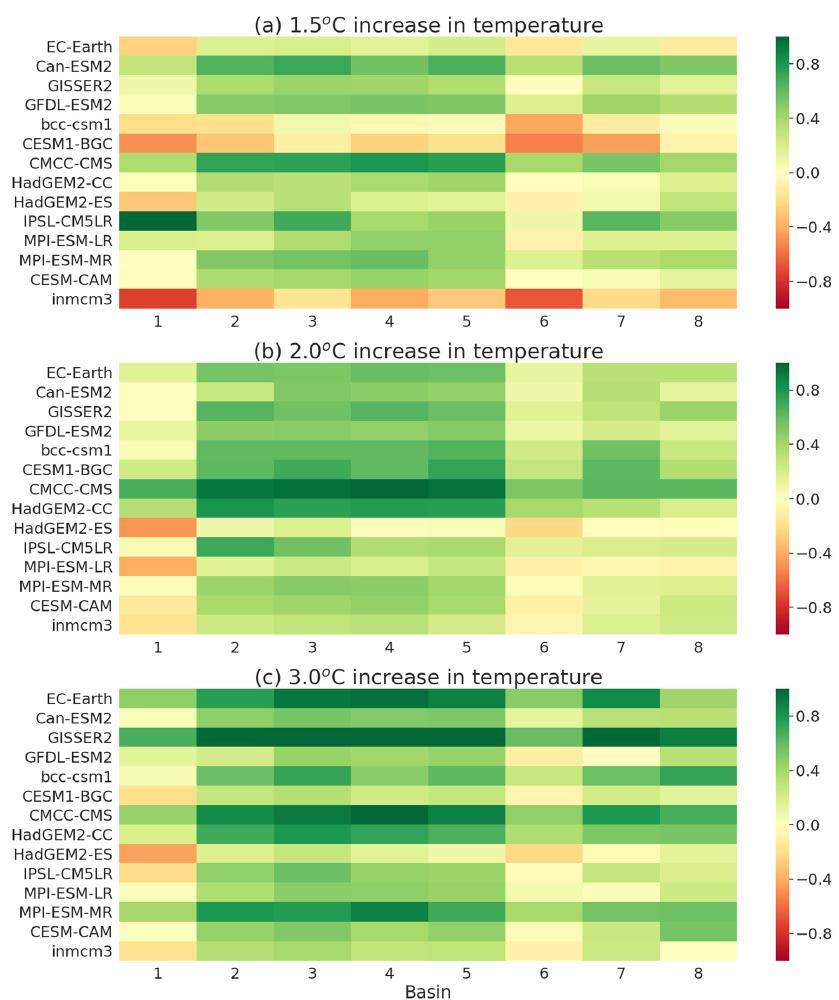
Figure 5. Average anomalies under different thresholds of temperature increases in the future compared to a base period